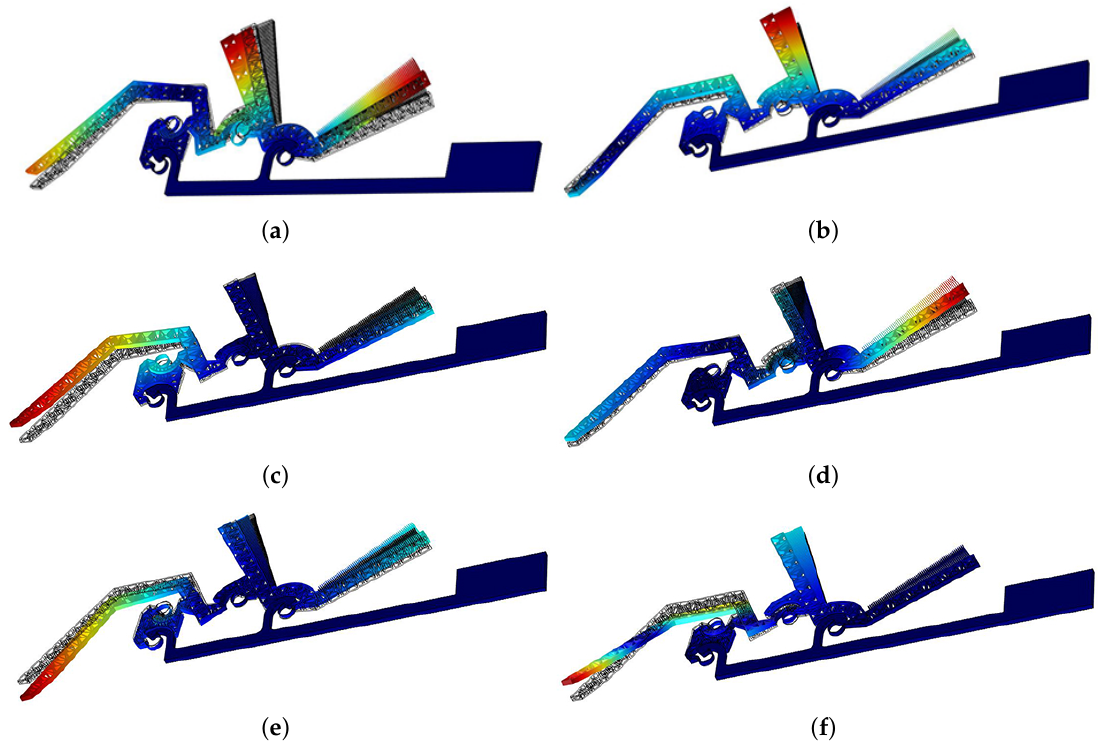
Figure 8. Eigenmodes and eigenfrequencies: first ( f 1 = 1.5147 kHz) ( a ); second ( f 2 = 1.9433 kHz) ( b ); third ( f 3 = 2.4749 kHz) ( c ); fourth ( f 4 = 2.9982 kHz) ( d ) ; fifth ( f 5 = 6.4103 kHz) ( e ); and sixth ( f 6 = 6.4618 kHz) ( f ) eigenmode,